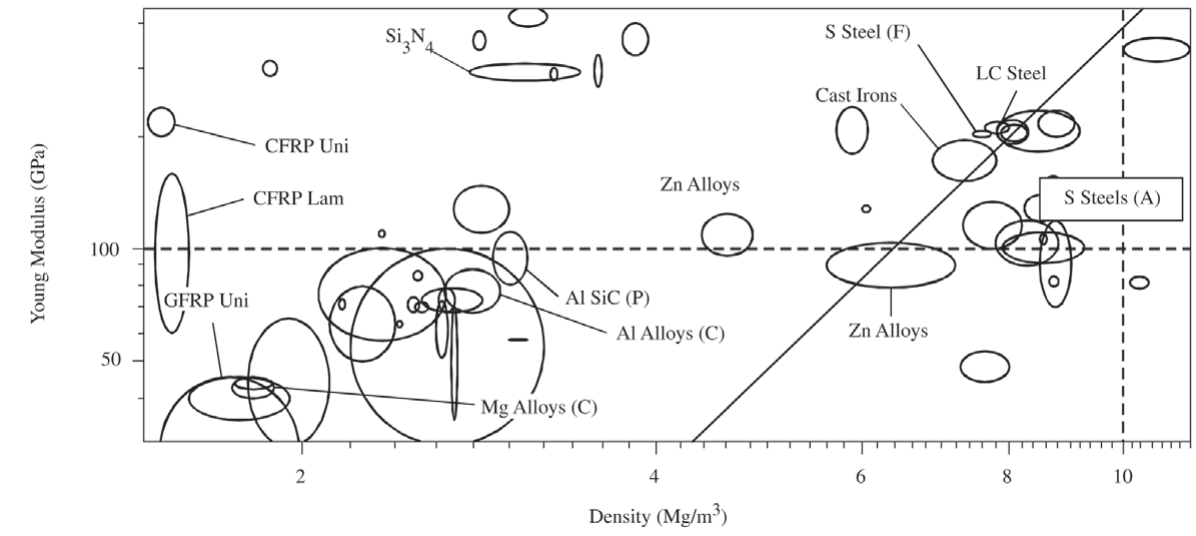
Figure 2. A region of the Young Modulus versus density map.